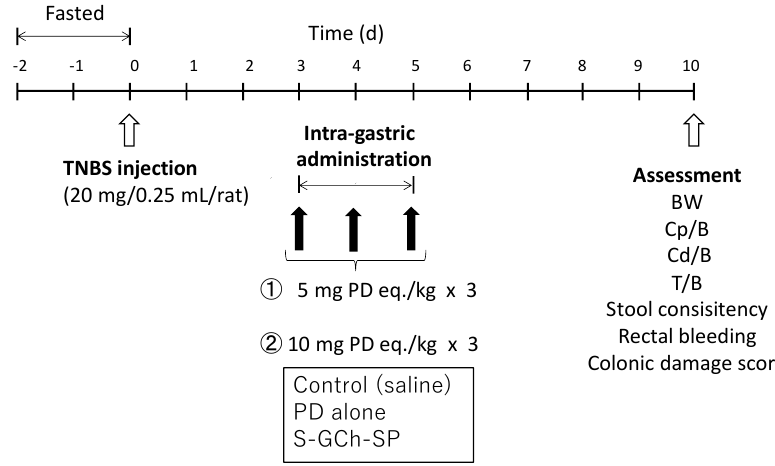
Figure 2. Animal experiment procedure to test the efficacy and toxic side effect. BW: body weight, B: body weight, Cp: proximal colon weight, Cd: distal colon weight, T: thymus weight.